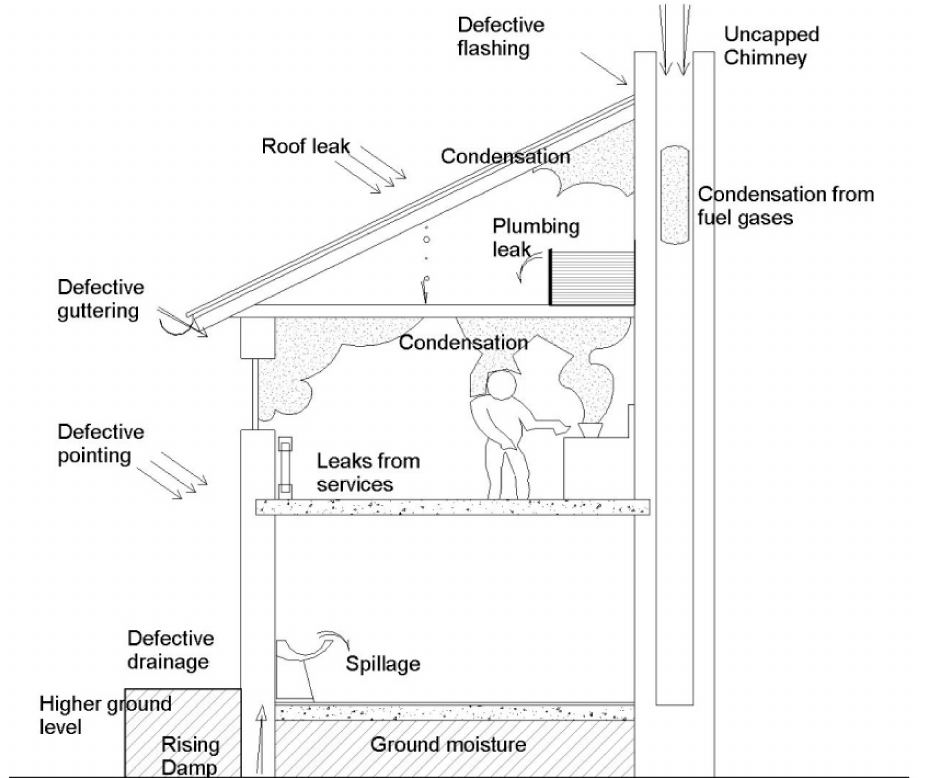
Figure 1. Illustration of the basic sources of